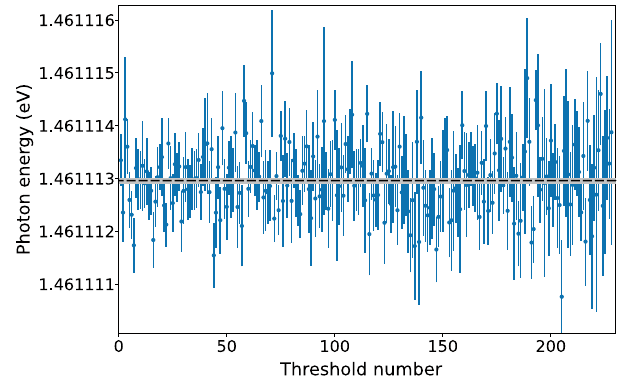
Fig.4|Allthresholdvaluesusedforthe fi nalelectronaf fi nity. The228individual threshold values used for the fi nal electron af fi nity determination are in blue. The uncertainties obtained from the individual fi ts are given as the error bars. The weighted arithmetic mean of the thresholds gives an electron af fi nity of 1.461,112,972(45)eV for oxygen. The electron af fi nity is illustrated by the dashed black line and the statistical 0.045 μ eV uncertainty is indicated by the gray area.